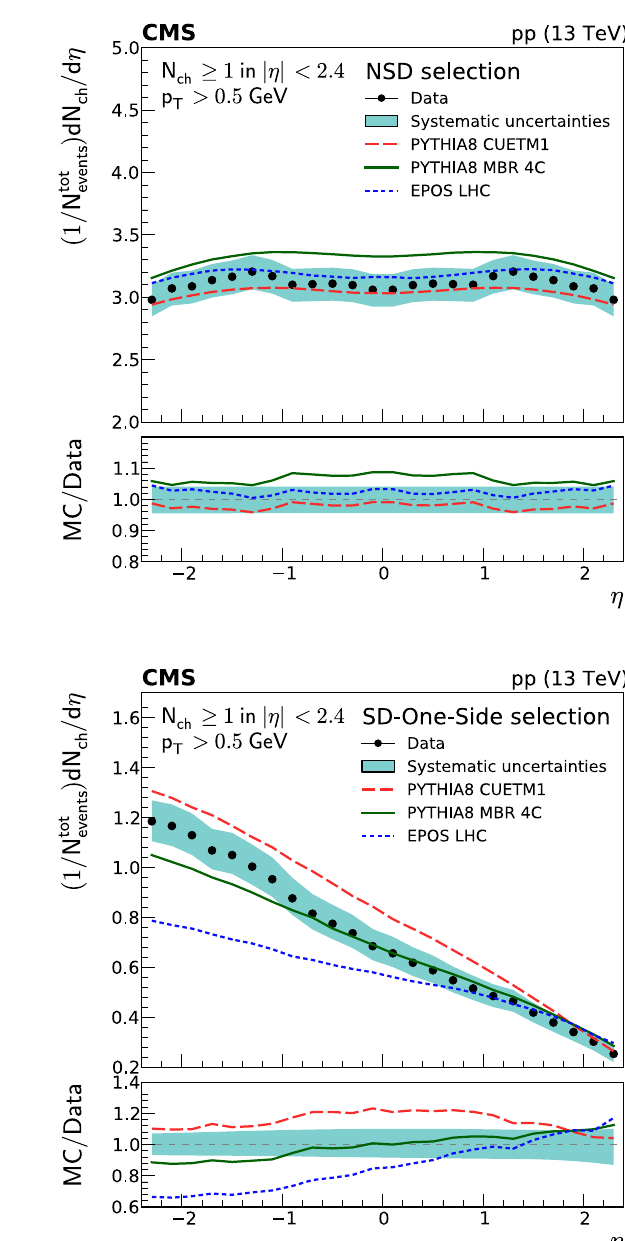
dashes) event generators. The band encompassing the data points rep- resent the total systematic uncertainty, while the statistical uncertainty is included as a vertical bar for each data point. The lower panels show the corresponding MC-to-data